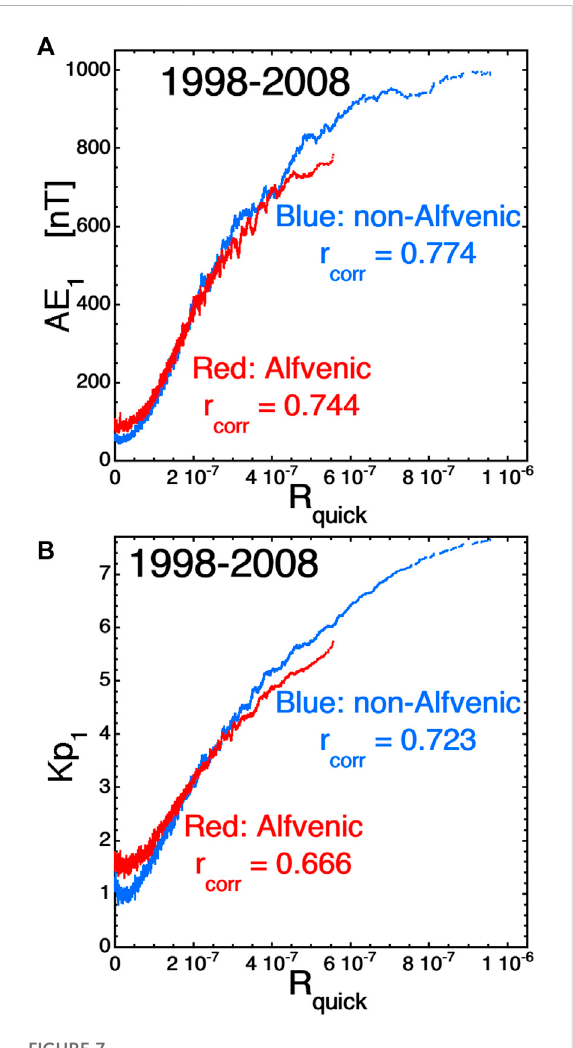
FIGURE 7 201-point running averages of AE 1 [panel (A) ] and of Kp 1 [panel (B) ] are plotted as functions of the solar-wind driver R quick separately for times when the solar wind was non-Alfvénic (blue, | A| < 0.75)andfortimeswhenthesolarwindwasAlfvénic(red, |A| >